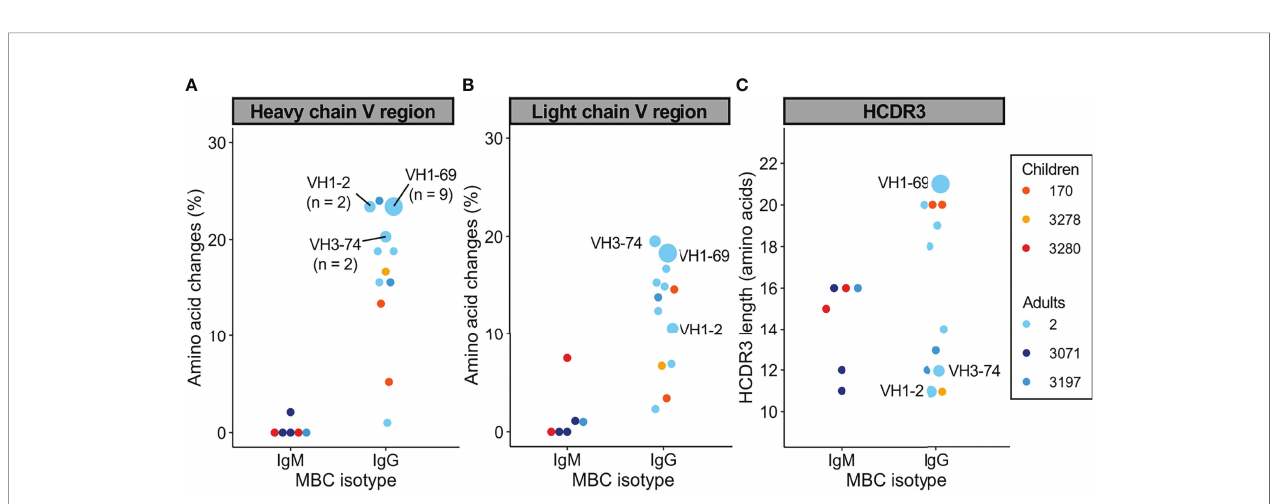
FIGURE 4 | Sequence analysis of the variable heavy and light chains of PfMSP1 FL-3D7 -speci fi c memory B cells. (A, B) Percentage of amino acid changes in the V gene segments of the heavy chain (A) and light chain (B) variable regions. (C) Length of HCDR3s. In all graphs, sequences from expanded clonal lineages were grouped. The VH gene usage and size of expanded clonal lineages are